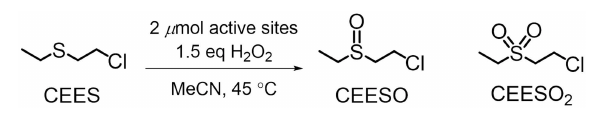
FIGURE 2 | Oxidation of CEES to CEESO and CEESO 2 under the conditions reported in Buru et al.